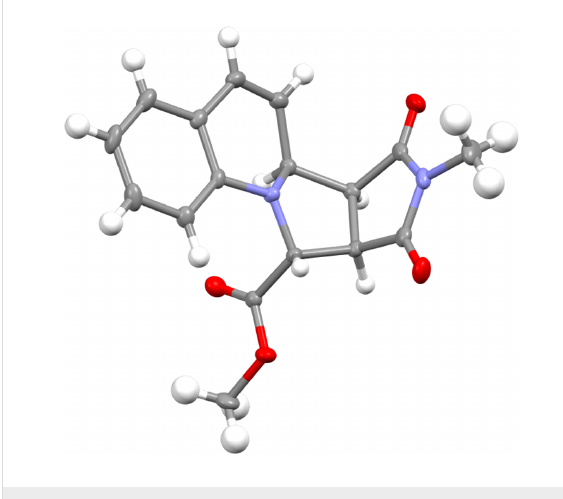
Figure 2: Single crystal X-ray structure for 9